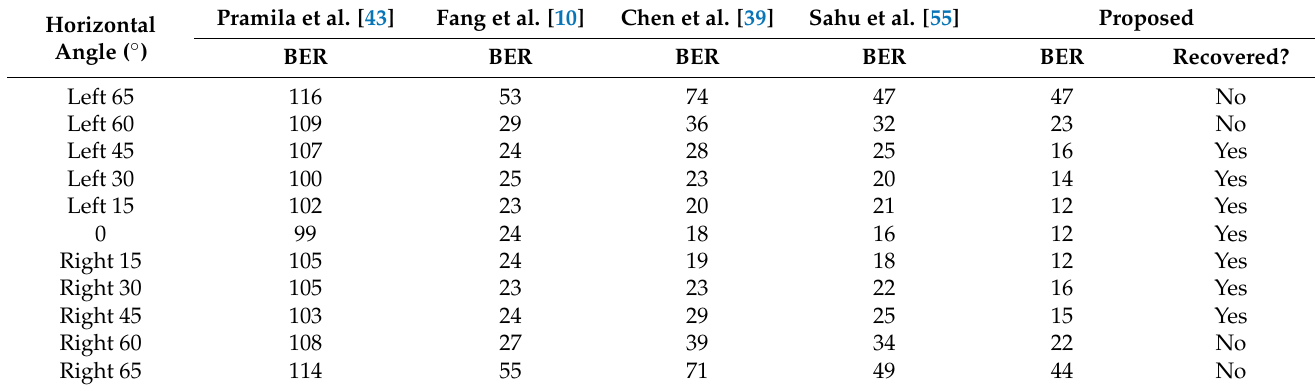
Table 7. BER values for the extracted watermark at different horizontal angles.